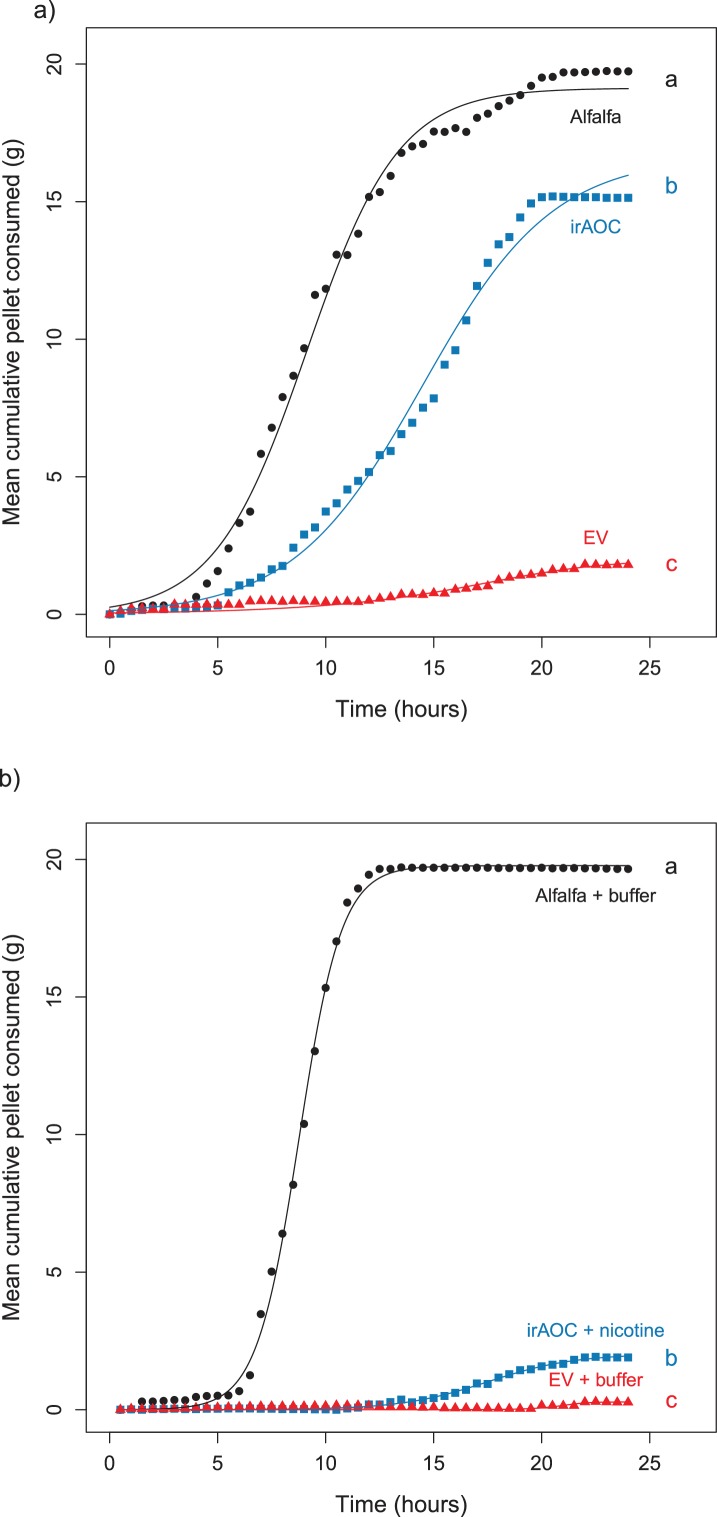
Results of the repetition of the feeding preference assays for cottontail rabbits (Sylvilagus nuttallii).Choice experiments were carried out with EV, irAOC and alfalfa pellets (a) (n = 8) or with EV, irAOC+nicotine and alfalfa pellets (b) (n = 9). Letters indicate significant differences in curve asymptotes tested based on asymptote confidence intervals of logistic models (p<0.001). Insets: nicotine contents of the different pellets. Letters indicate significant differences (p<0.05). N.D: not detected.